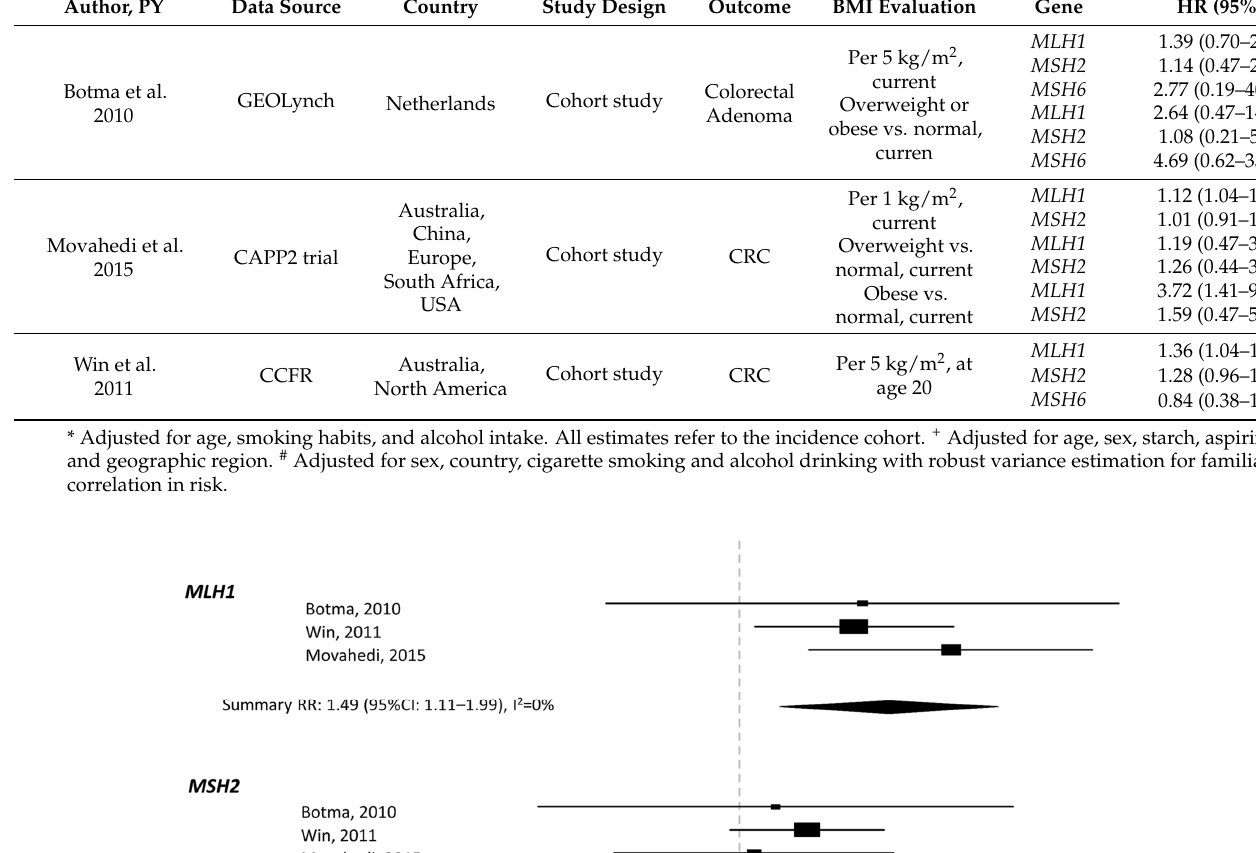
Figure 2. Forest plot of the association between colorectal cancer risk for obese vs. nonobese in subjects with Lynch Syndrome by sex. RR: relative risk. CI: confidence intervals. Table 2 shows the relationship between BMI and CRC risk in LS patients by MMR gene. Table 2. Correlation between BMI and CRC risk in LS patients by MMR gene.